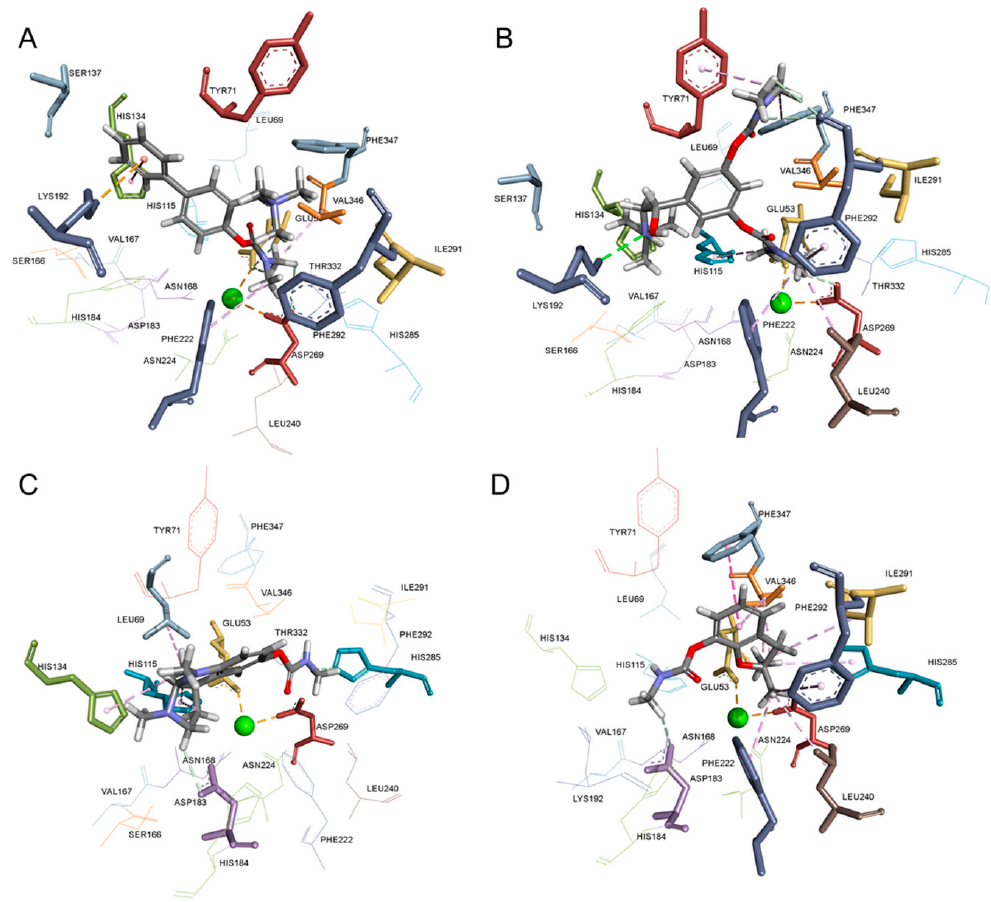
Figure 7. Simulation of the dissociation complex of PON1 and Ro 02-0683 ( A ), bambuterol ( B ), physostigmine ( C ), and carbofuran ( D ). Interactions are presented with green (H-bonds), orange (cation- π interaction), and purple (hydrophobic interactions) dashed lines. Residues Tyr71, His134, Asn168, Phe222 and Val346 are singled out as important for the stabilisation of substrate PTA. Table 5. PON1-carbamate complex binding interactions with the active site gorge residues evaluated by molecular docking. The crystal structure of PON1 used was PDB ID 1V04. Type of Interaction Carbamate H-bond π Interactions